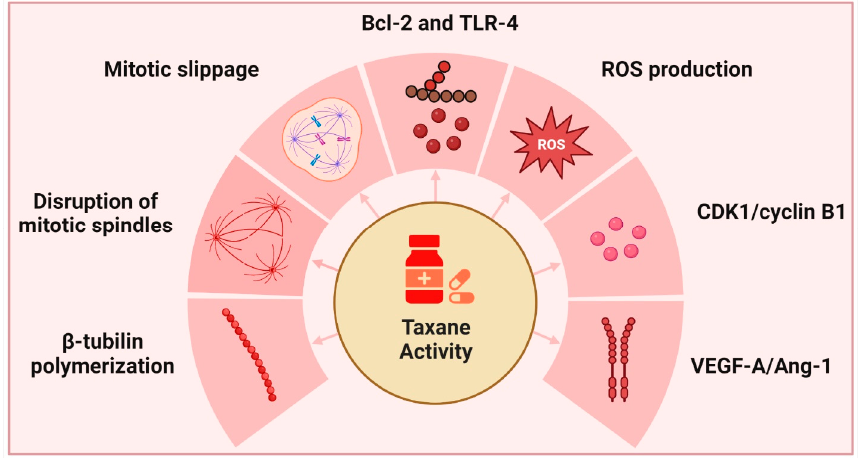
Figure 2. Taxanes and their primary modes of